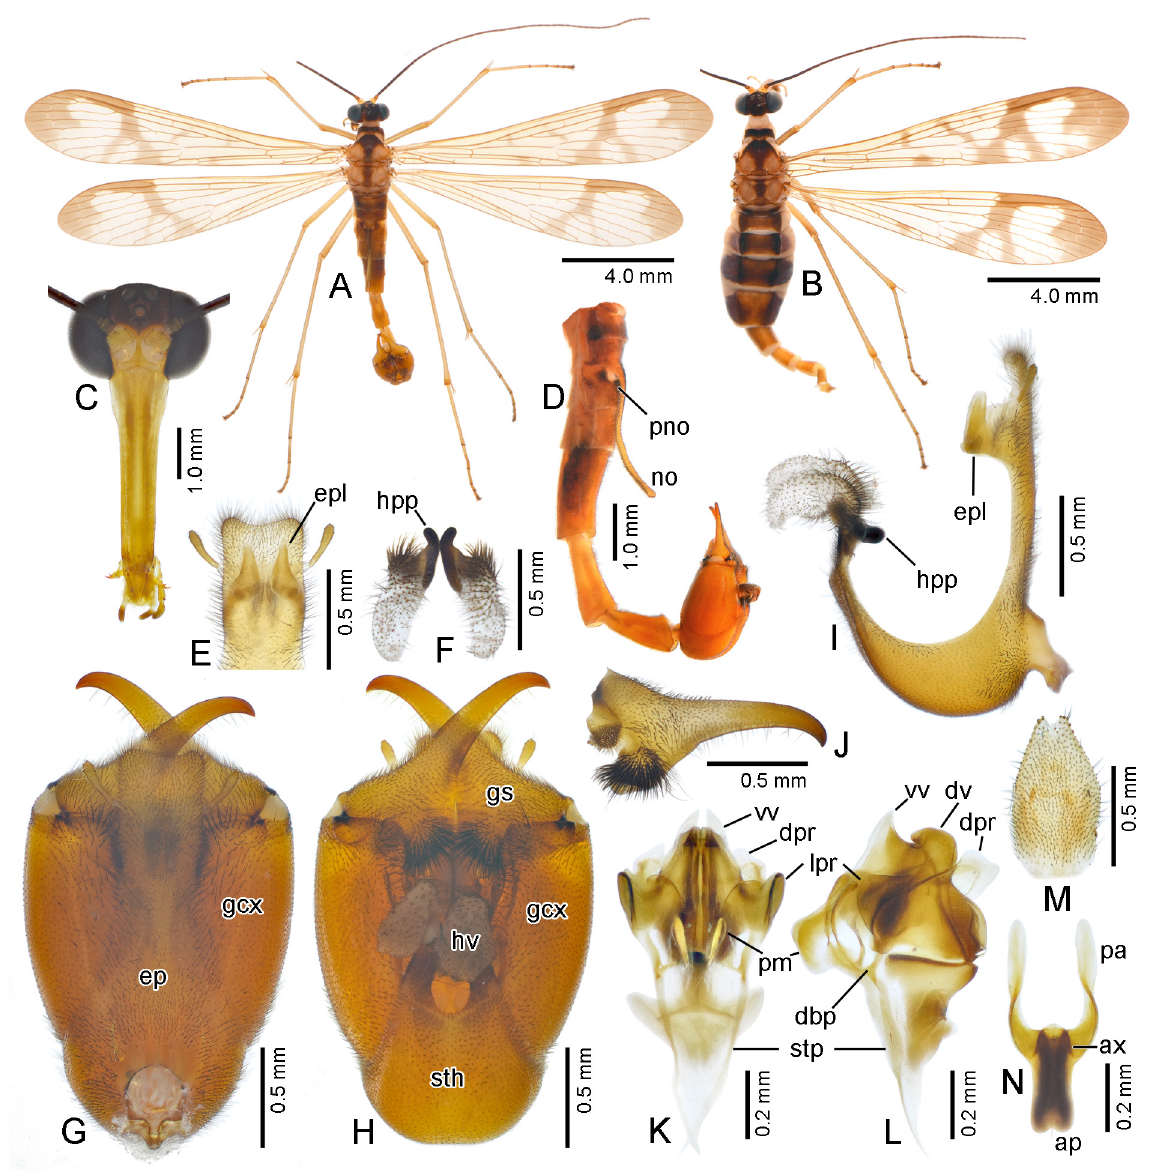
Fig. 3. Neopanorpa xingmini Wang & Hua sp. nov., paratypes (NWAU). A , C ‒L. Male. A . Habitus, dorsal view. C . Head, frontal view. D . Abdomen, left-lateral view. E . Apical portion of epandrium, ventral view. F . Hypovalves, caudal view. G – H . Genital bulb, dorsal and ventral views, respectively. I . Epandrium and hypandrium, right-lateral view. J . Left gonostylus, ventral view. K – L . Aedeagal complex, ventral and right-lateral views, respectively. – B , M – N . Female. B . Habitus, dorsal view. M . Subgenital plate, ventral view. N . Medigynium, ventral